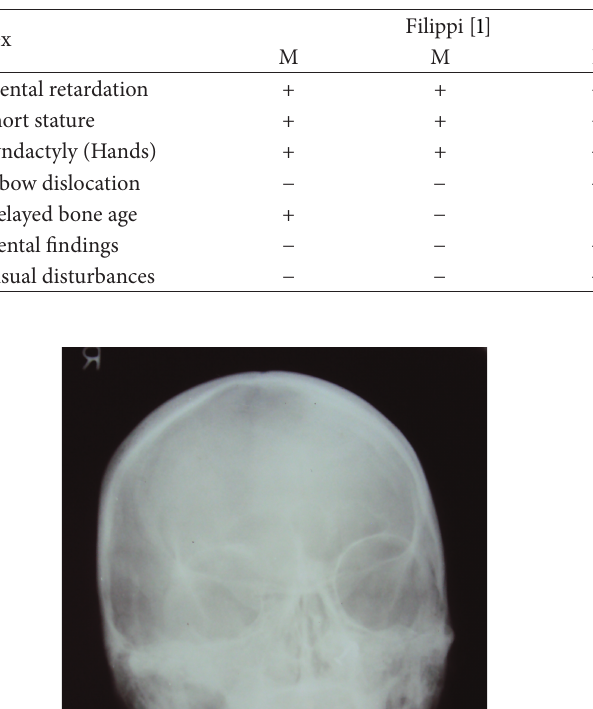
Table 2: Clinical features in six patients with Filippe syndrome.